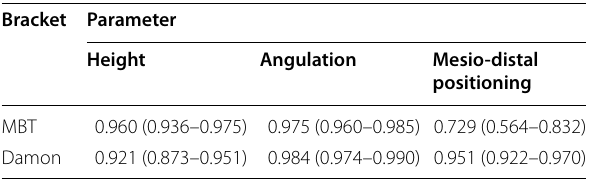
Table 1 Interclass coefficient values for each bracket type and for each parameter Bracket Parameter